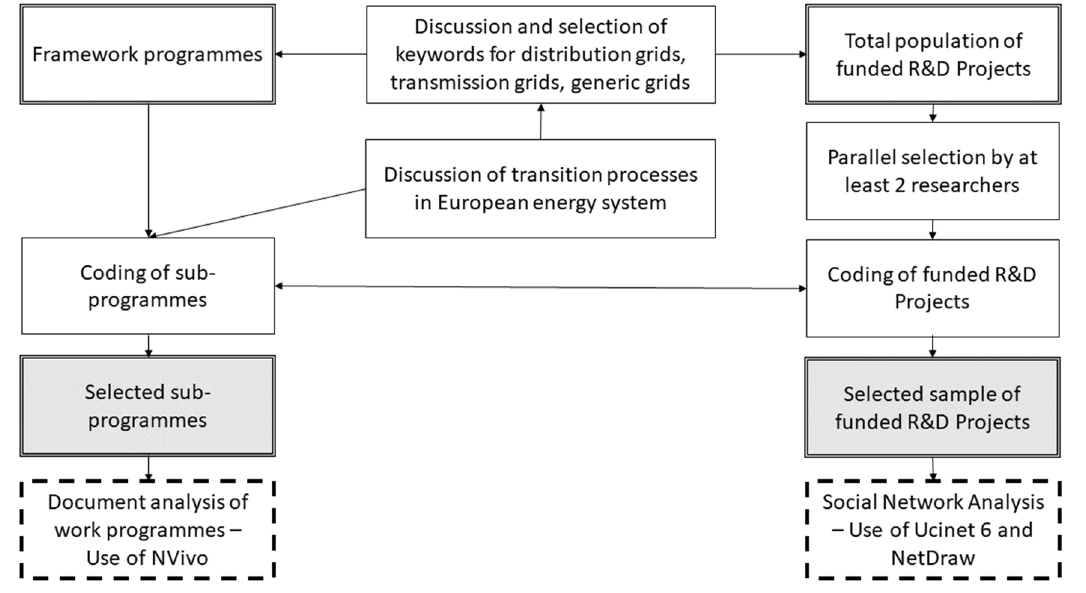
Figure 1. Flow chart of the methodical